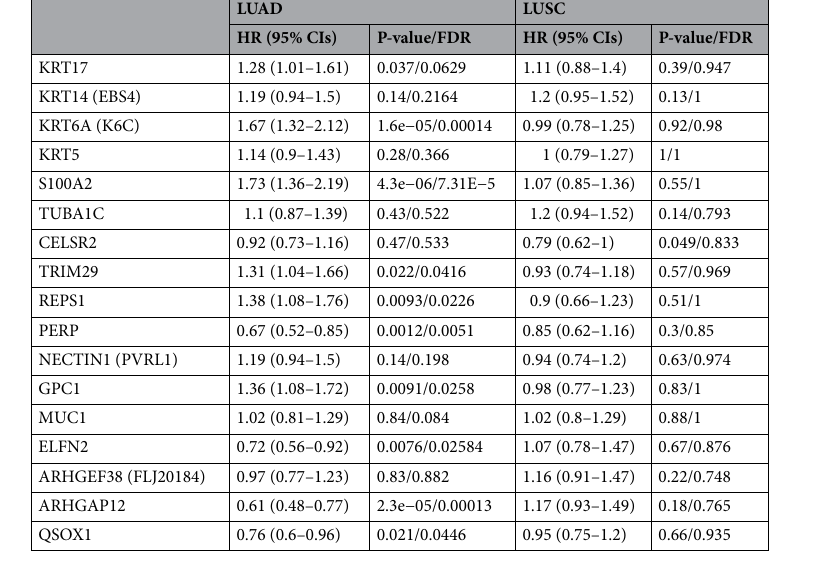
Table 4. Kaplan Meier prognostic values of the 17 biomarker.